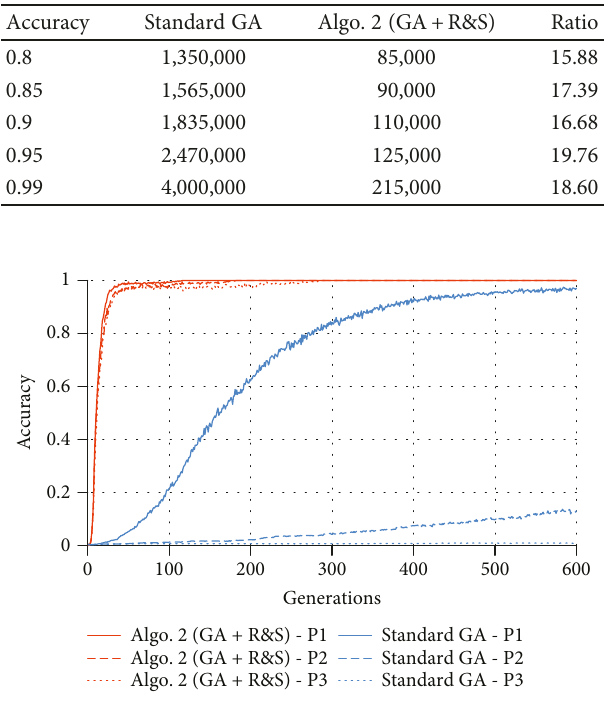
Figure 11: The accuracy curves of Algorithm 2 and the standard GA according to the three di ff erent settings of the algorithm parameters: P1, P2, and P3.